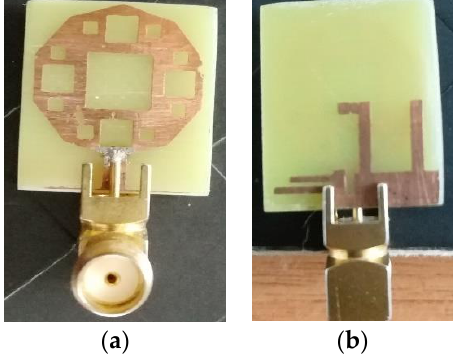
Figure 34. Proposed UWB notch antenna fabrication: ( a ) top portion ( b ) bottom portion.